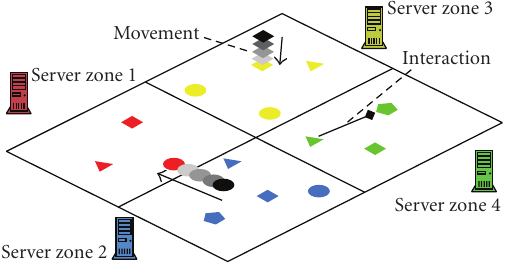
Figure 10: A zoned world distributed on four servers.